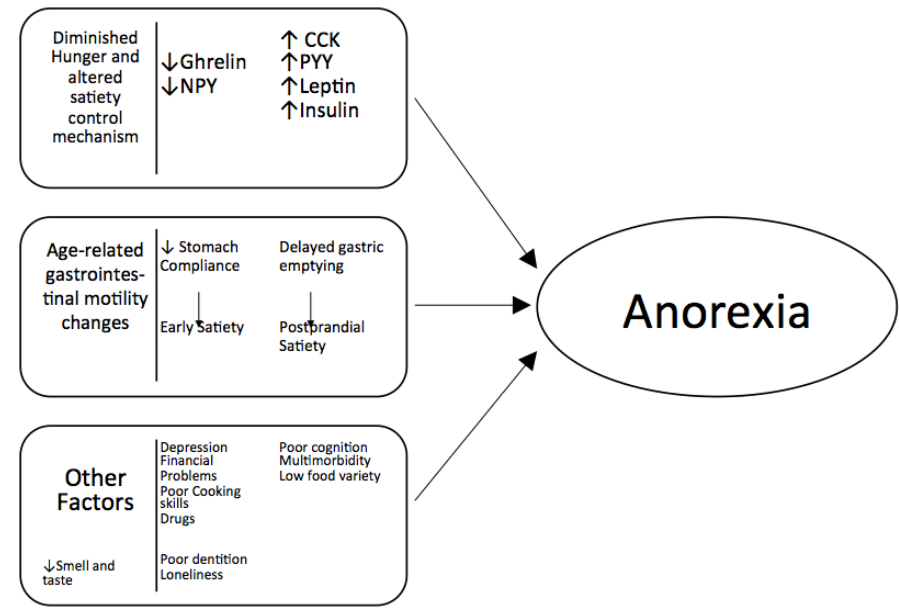
Figure 1. Major mechanisms involved in the development of anorexia of aging.